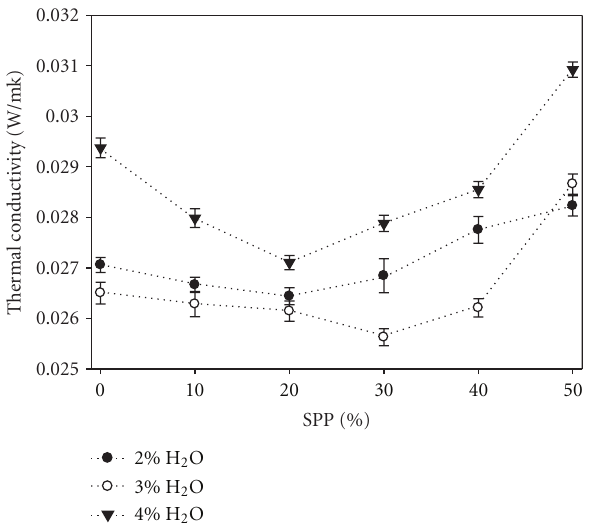
Figure 5: E ff ect of SPP percentage on compressive strength of rigid PU foams with di ff erent water